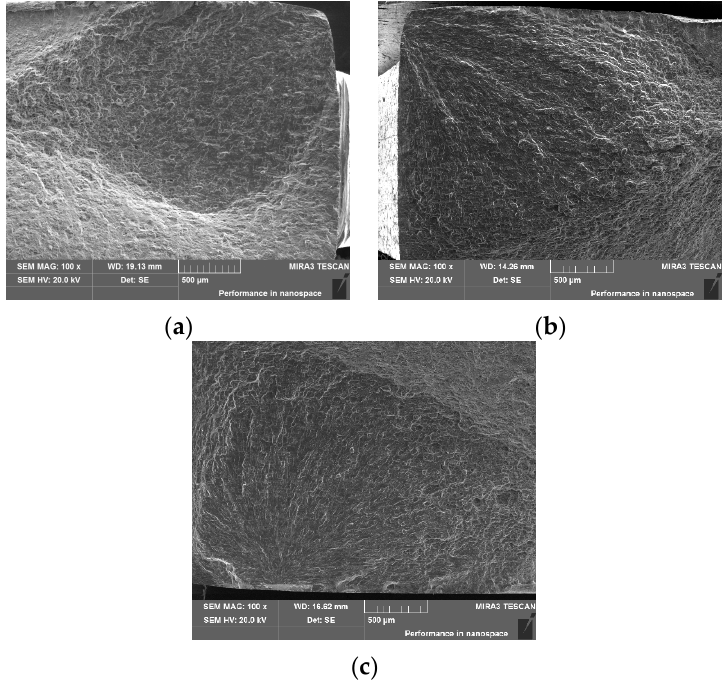
Figure 2. The overall morphology of the fatigue fractures: ( a ) T3; ( b ) AA; ( c ) CA.